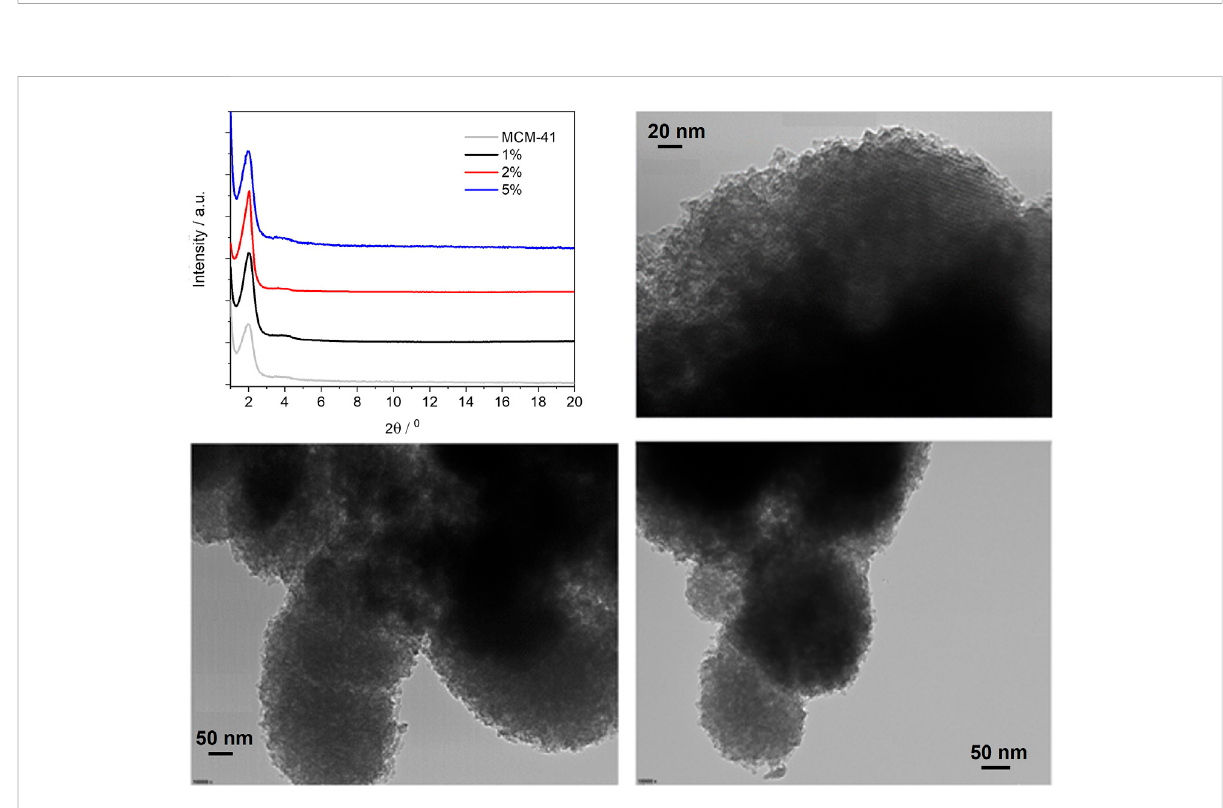
FIGURE 4 Powder X-raydiffractionpatternsoftheBOPHY1-PMO materials(topleft); TEMimages of1%(topright),2%(bottom left)and5%(bottom